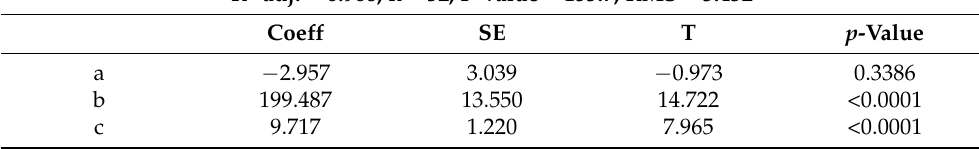
Table 4. Regression equation for associating harvesting cost with field stocking and log length specifications.